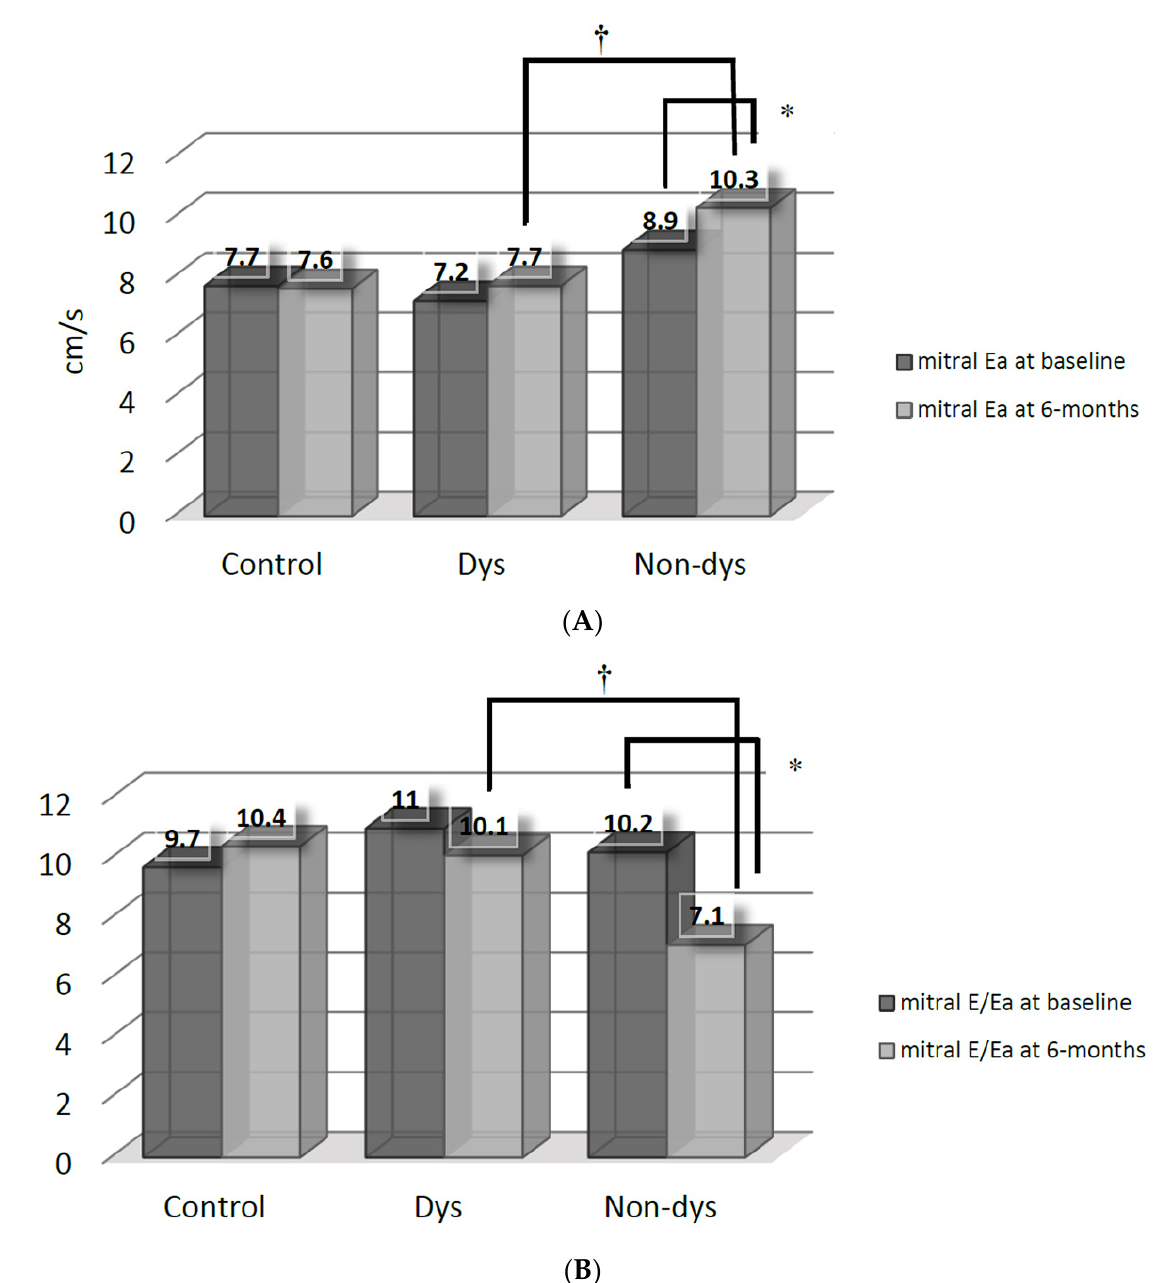
Figure 2. ( A ) Comparisons of mitral annular early diastolic velocity (Ea) between the dyssynchrony (Dys) and non-dyssynchrony (Non-dys) groups at baseline and at 6 months after spironolactone therapy. * p < 0.05 versus baseline; † p < 0.05 between the Dys and Non-dys subgroups. ( B ) Comparisons of mitral E-flow/annular early diastolic velocity (Ea) between the dyssynchrony (Dys) and non-dyssynchrony (Non-dys) groups at baseline and at 6 months after spironolactone therapy. * p < 0.05 versus baseline; † p < 0.05 between the Dys and Non-dys subgroups.